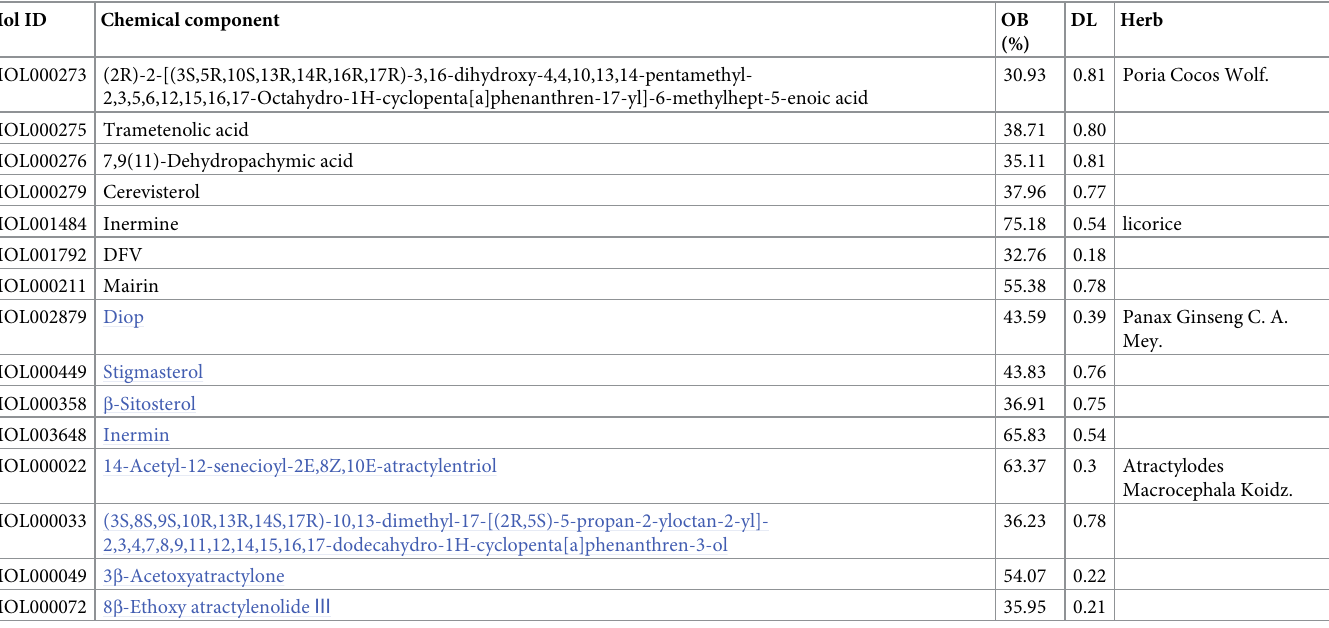
Table 1. Basic information for some active components of